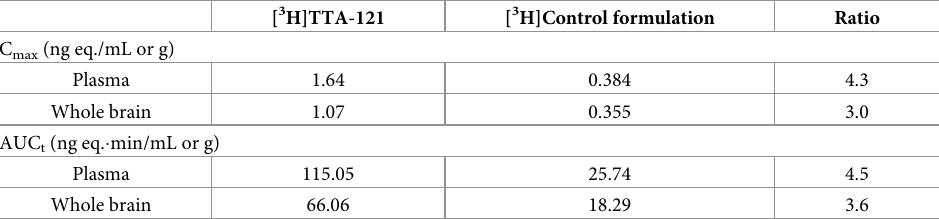
Table 3. PK parameters in plasma and whole brains after single intranasal administration of [ 3 H]TTA-121 and [ 3 H]control formulation to male rabbits (dose: 4